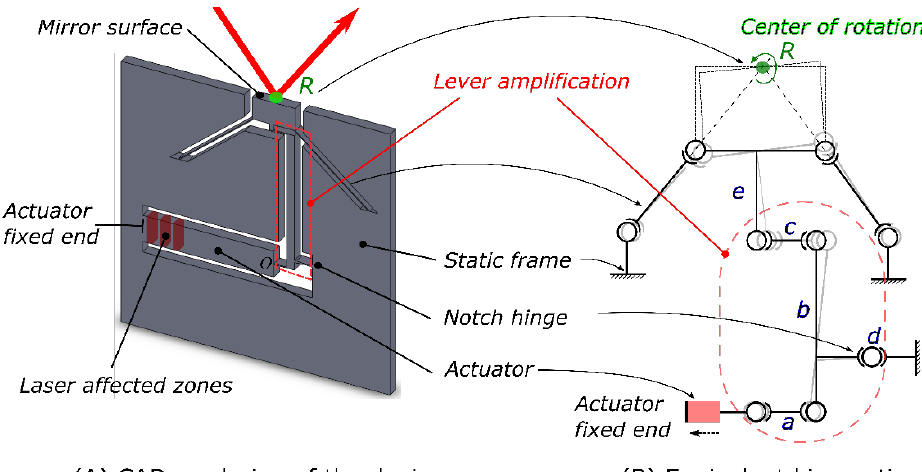
Figure 1. ( A ) Computer-aided design (CAD) drawing of a proof-of-concept of laser-tunable gimbal mirror. ( B ) Schematic of the mirror kinematics. The strain inside the actuator is coupled through a thin beam (a) to the lever arm (b). A second thin beam at the top (c) ultimately pulls on the mirror through (e) to cause a rotation. The lever mechanism is implemented through a circular notch hinge (d) fabricated by the same process. As the actuator is exposed, there is a net displacement towards the left and a subsequent rotation of the mirror. A deformed state of the mirror is shown in light gray.